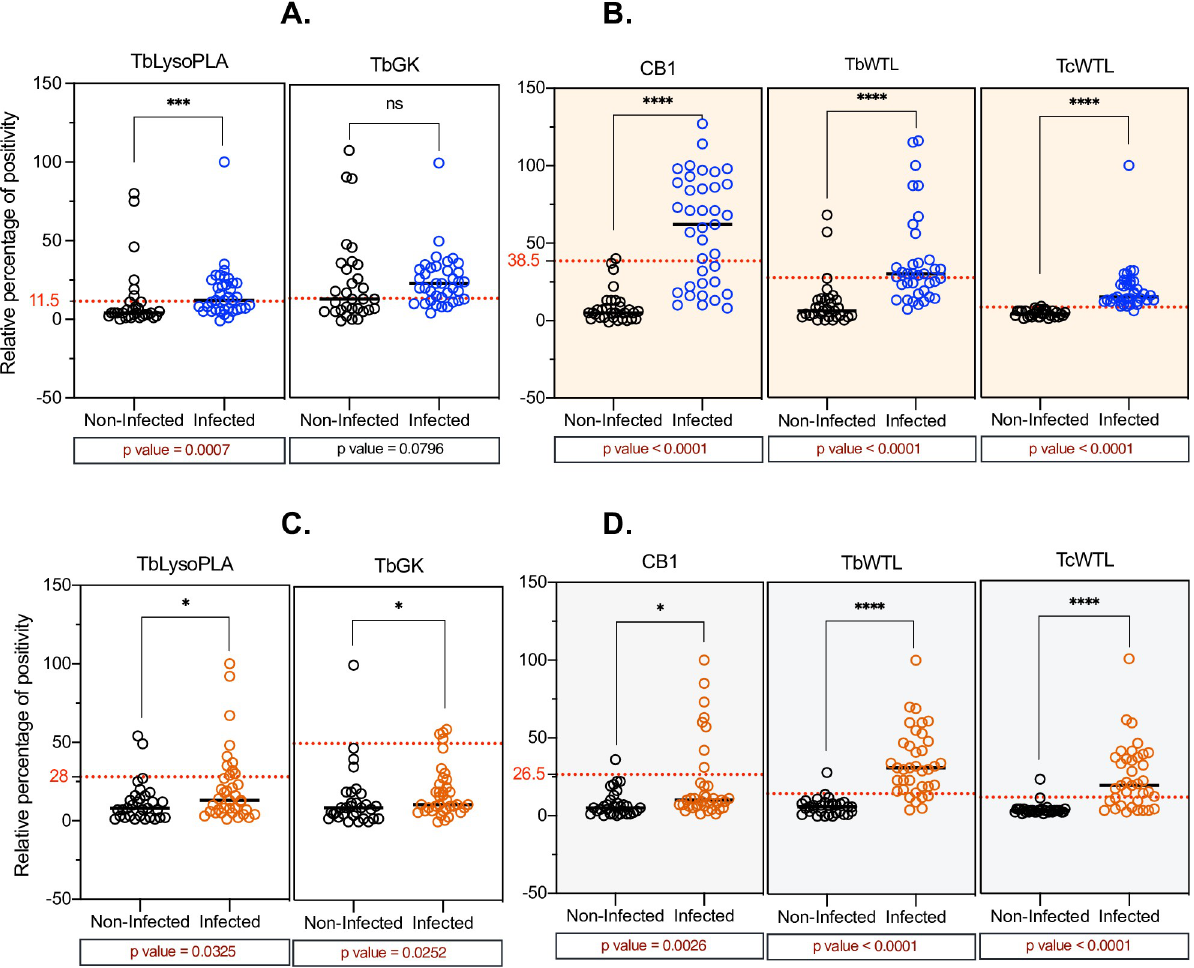
Fig 3. Evaluation of the diagnostic potential of TbLysoPLA and TbGK in indirect ELISA. (A-B) bovine sera from T. congolense experimental infection. (C-D) Field sera from T. congolense, T. vivax and T.b. brucei naturally infected cattle. A total of 74 positive (infected) and 62 negative (non- infected) samples were tested. TcoCB1 antigen was used as recombinant antigen control and TbWTL, TcWTL (T.b. brucei and T. congolense total lysates respectively) were used as reference antigens (current OIE recommended antigens in AAT diagnosis). The optimal cut-off value for each antigen is shown by a red dashed